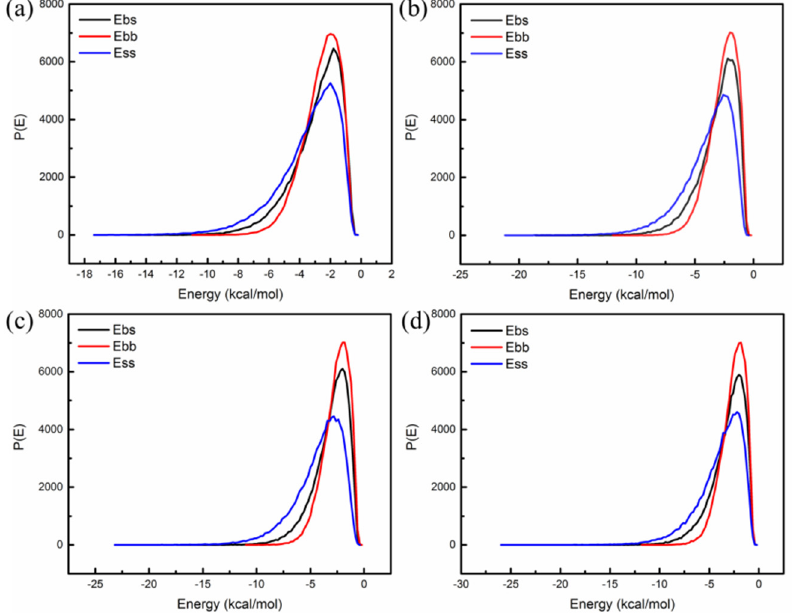
Figure 11. The probability distribution of mixing energy of SBS with asphalt blends: ( a ) matrix asphalt/SBS; ( b ) 5 Å nano-OvPOSS/asphalt/SBS; ( c ) 7 Å nano-OvPOSS/asphalt/SBS; ( d ) 9 Å nano-OvPOSS/asphalt/SBS.